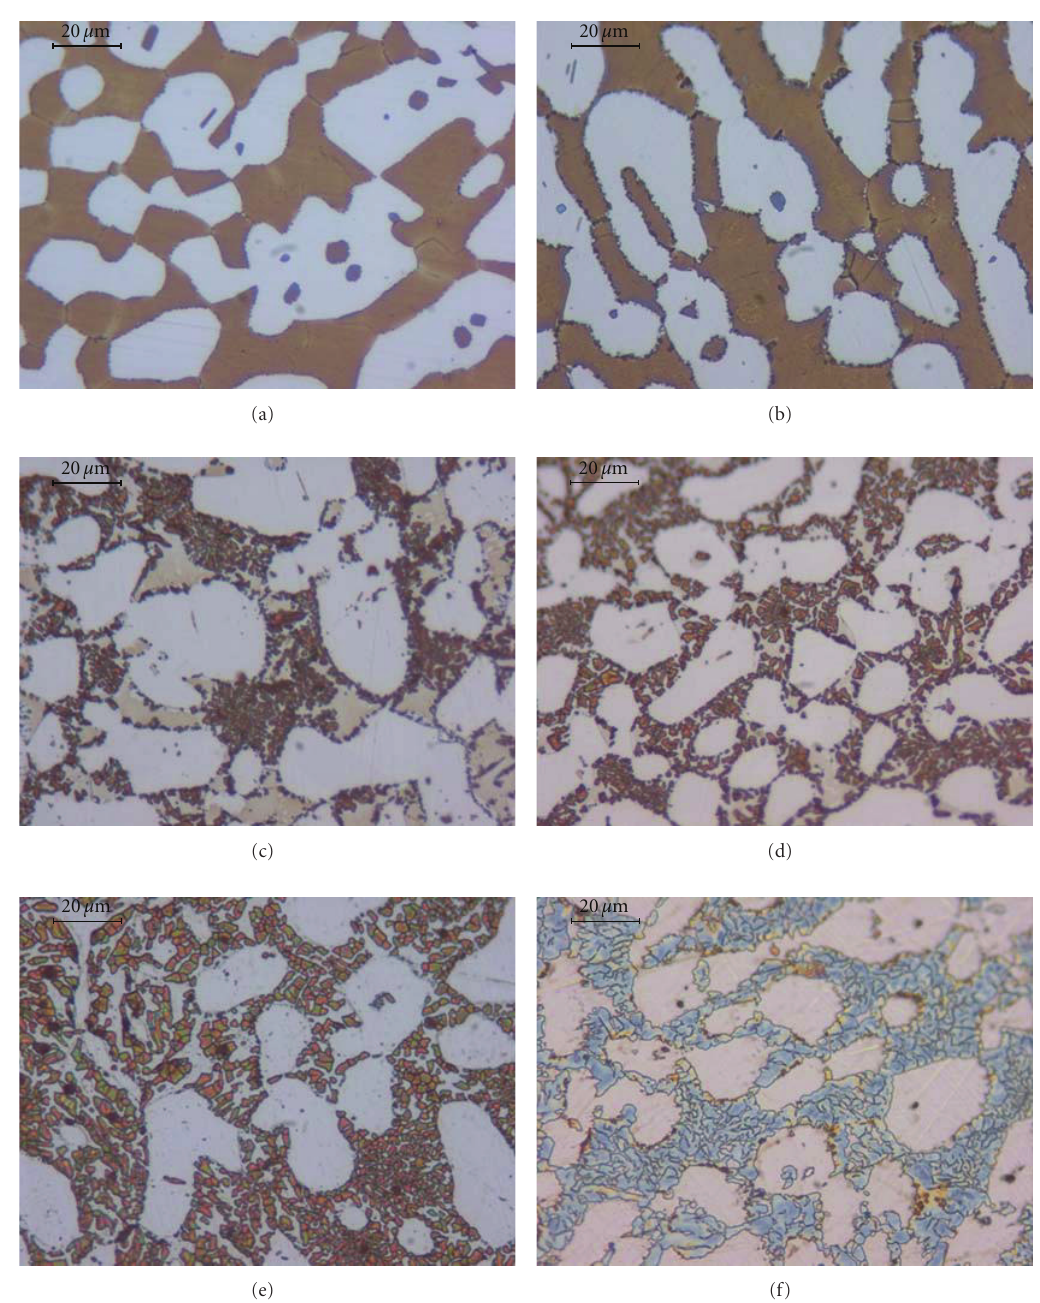
Figure 2: Optical micrographs obtained after ageing at 725 ◦ C by etching with NaOH reagent (a) 100 min, (b) 316 min, (c) 1000 min, (d) 3162 min, (e) 10000 min, (f) 31622 min (austenite in white, ferrite in gray, sigma precipitates in